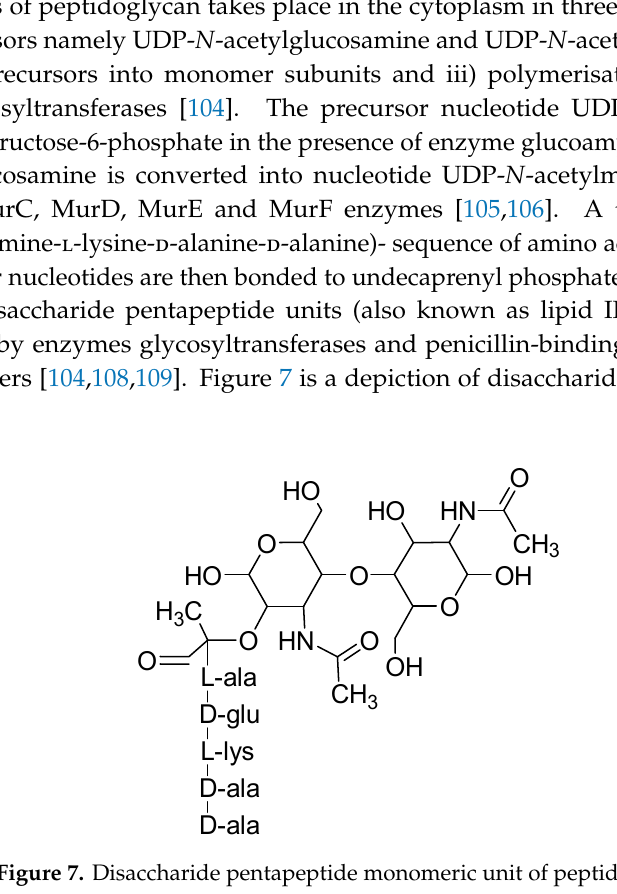
Figure 8. Pentaglycine cross ‐ linkages in Gram ‐ negative and Gram ‐ positive bacterial peptidoglycan. Disaccharide pentapeptide monomer in Gram ‐ negative bacterial peptidoglycan possesses meso ‐ diaminopimelic acid (mDAP), whereas Gram ‐ positive bacterial peptidoglycan has L ‐ lysine instead. Basic concept (with adaptations) has been drawn from Irazoki, Hernandez, and Cava, 2019 [111]. Figure 8 has been drawn using Microsoft Word.